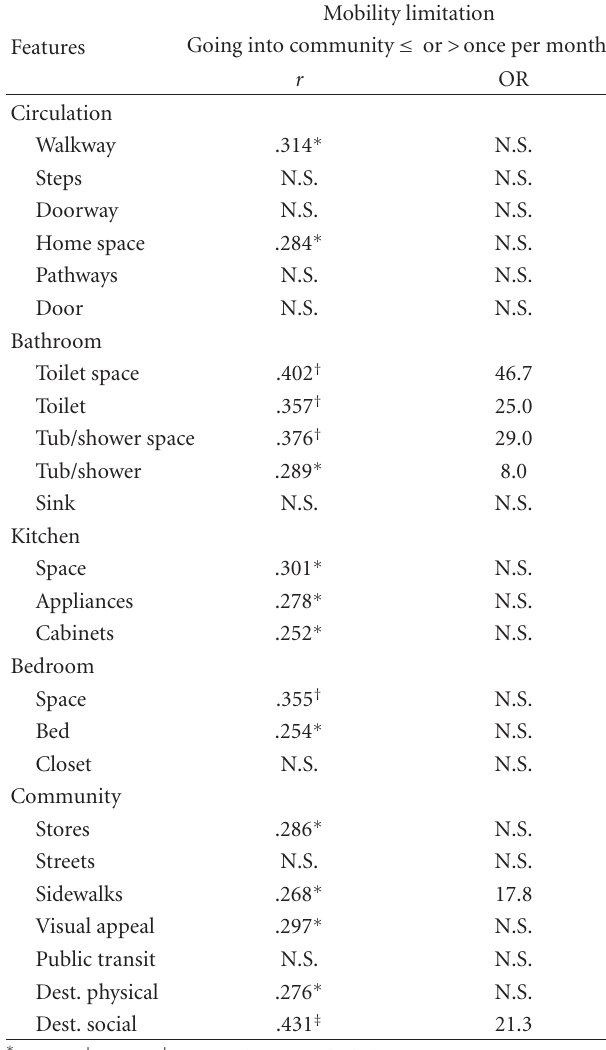
Table 6: Correlations between environmental features and commu- nity participation and odds ratio